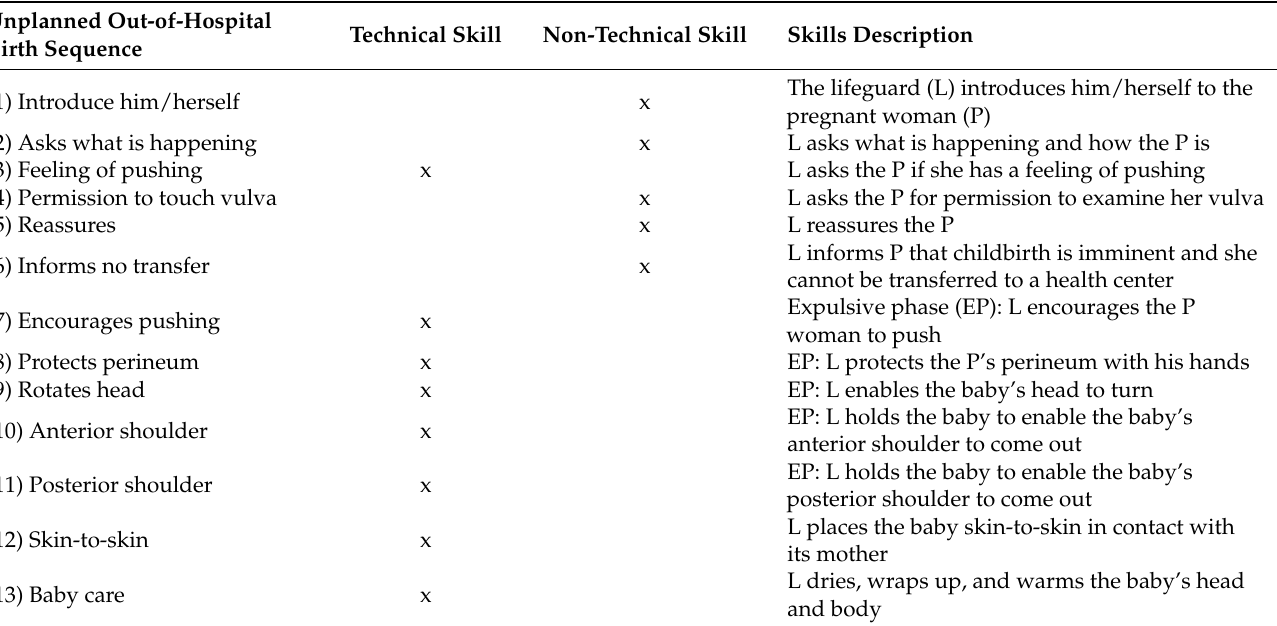
Table 1. Unplanned out-of-hospital birth sequence, classification into technical or non-technical skills, and description of the